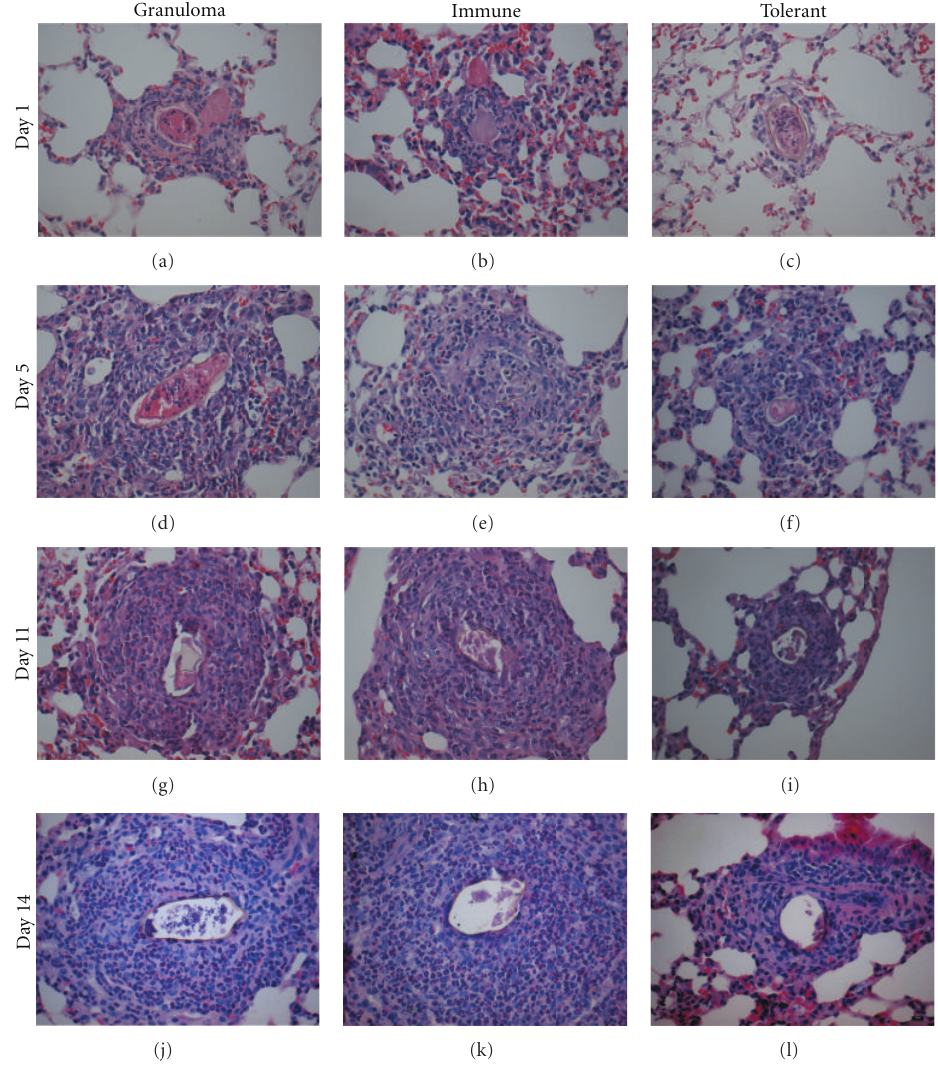
Figure 2: Granuloma at di ff erent times after egg injection. Lung HE staining 1, 5, 11, and 14 days after i.v. injection of S. mansoni eggs. (a–c) At day 1, an inflammatory infiltrate with predominance of neutrophils and macrophages can be detected around eggs in all groups, but it is less intense in the tolerant group. (d–f) At day 5, macrophages, eosinophils, and some lymphocytes can be detected. (g–l) At days 11 and 14 granulomas are more organized and some fibroblasts can be detected. Granulomas in tolerant mice follow the same pattern of organization but do not reach the same size of granulomas in controls group. Scale bars = 25 μ